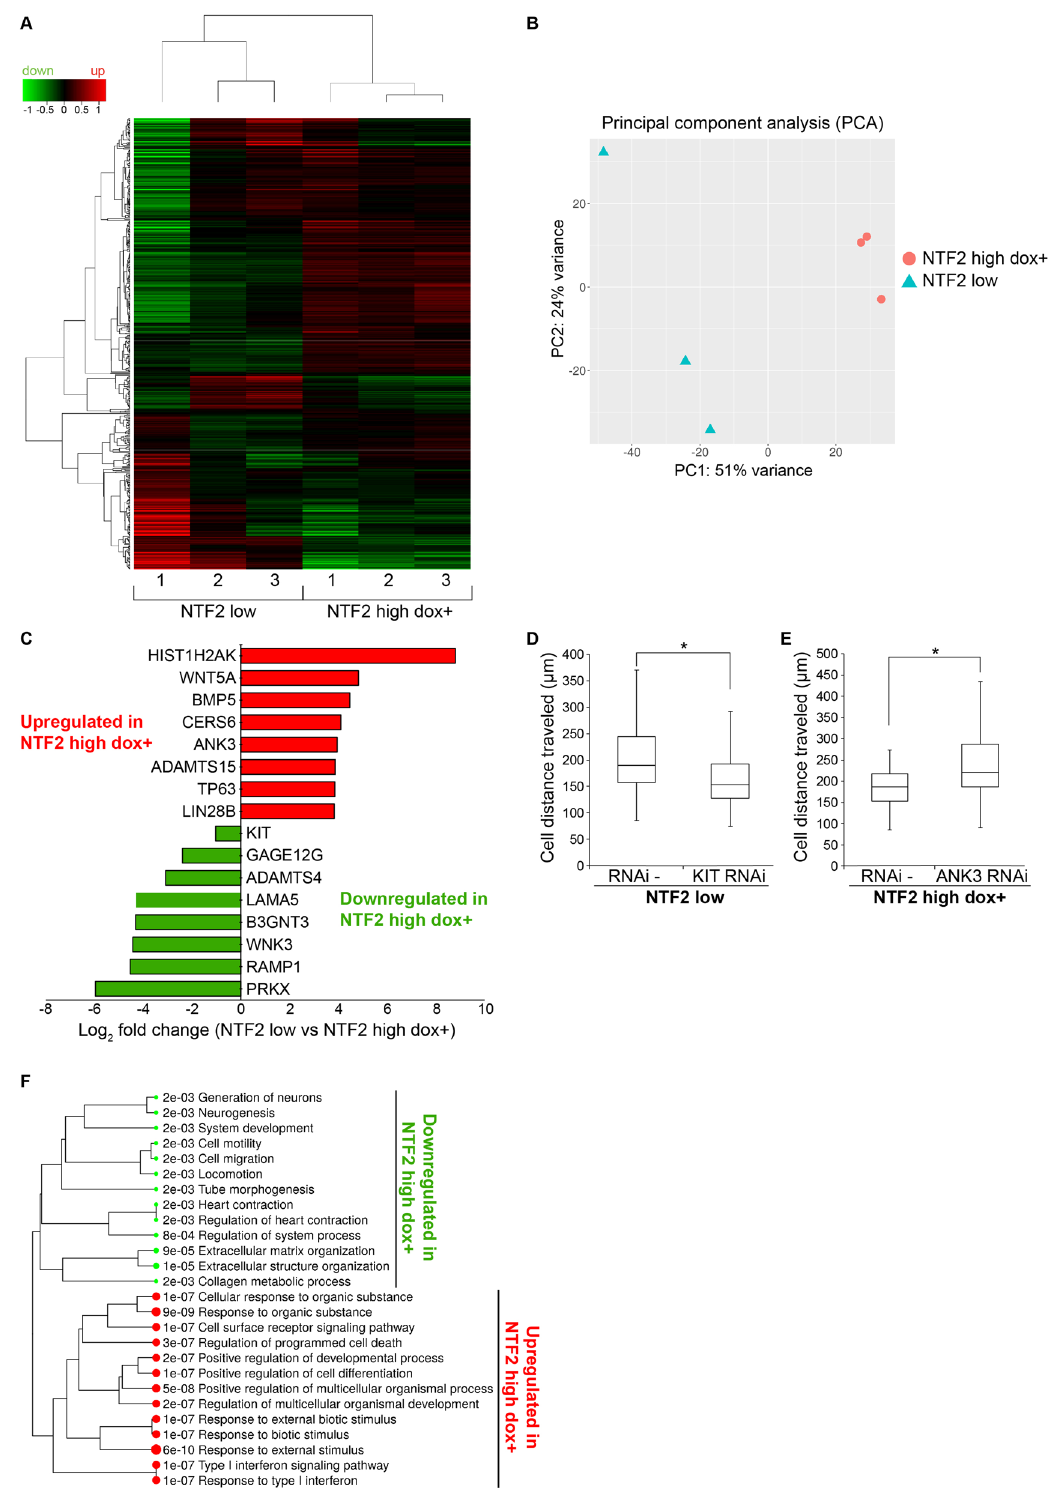
Figure 4. Increasing NTF2 levels alters expression of cancer- and cell migration-related genes. RNAseq data were acquired for three independent samples each of NTF2 low and NTF2 high dox + cells. Also see Table S1. (A) Expression heat map of the 500 most differentially expressed genes with hierarchical clustering. Red and green represent genes upregulated and downregulated, respectively, relative to a reference transcriptome. The Z score cut-off was 4. (B) Two-dimensional principal component analysis (PCA) is shown. (C) Based on log 2 fold change ranking, the most highly upregulated and downregulated cancer-related genes in NTF2 high dox + cells are shown. (D-E) KIT gene expression was knocked down by siRNA in NTF2 low cells. ANK3 gene expression was knocked down by siRNA in NTF2 high dox + cells. Individual cell migration over 10 h was assayed and quantified as in Fig. 2D,E for at least 30 cells per condition from two independent experiments. Boxes indicate the upper quartile, median, and lower quartile values. Whiskers indicate the largest and smallest values. Two-tailed Student’s t-tests assuming equal variances with *p < 0.05. (F) Enriched pathways are listed for differentially expressed